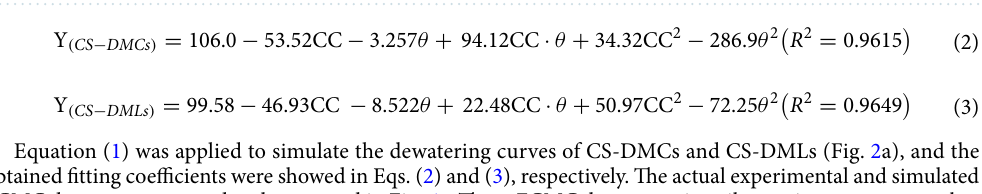
Figure 5. The intensities of various 3D-EEM characteristic peaks of ( a ) S-EPS, ( b ) LB-EPS, and ( c ) TB-EPS in sludge treated by the St-based